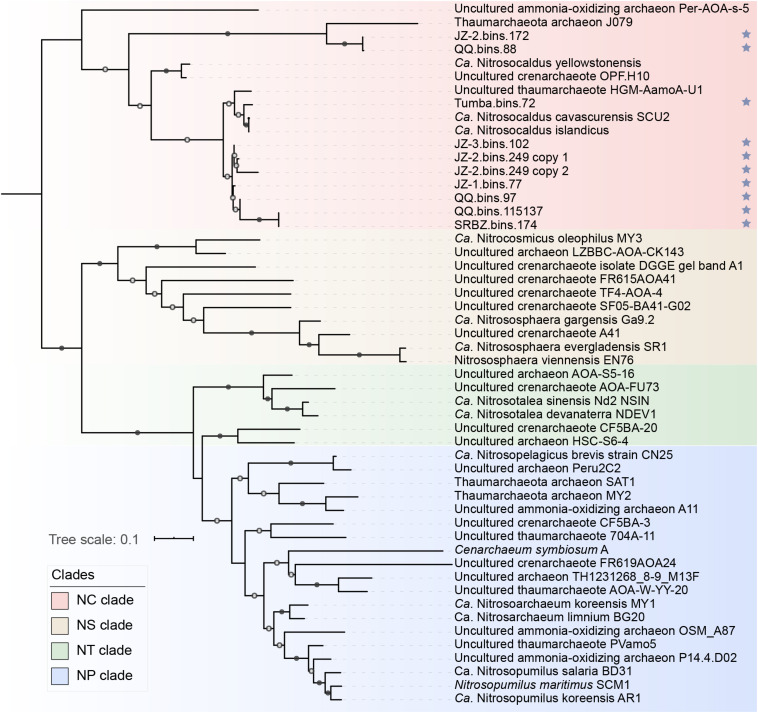
Phylogenetic analysis of amoA gene sequences. Sequences with blue stars were newly obtained in this study. Classifications of clades were based on Alves et al. (2018). Only nodes with ultrafast bootstrap values ≥95% (50%) were marked with solid (hollow) circles, and the scale bar at the bottom indicates 10% sequence divergence.